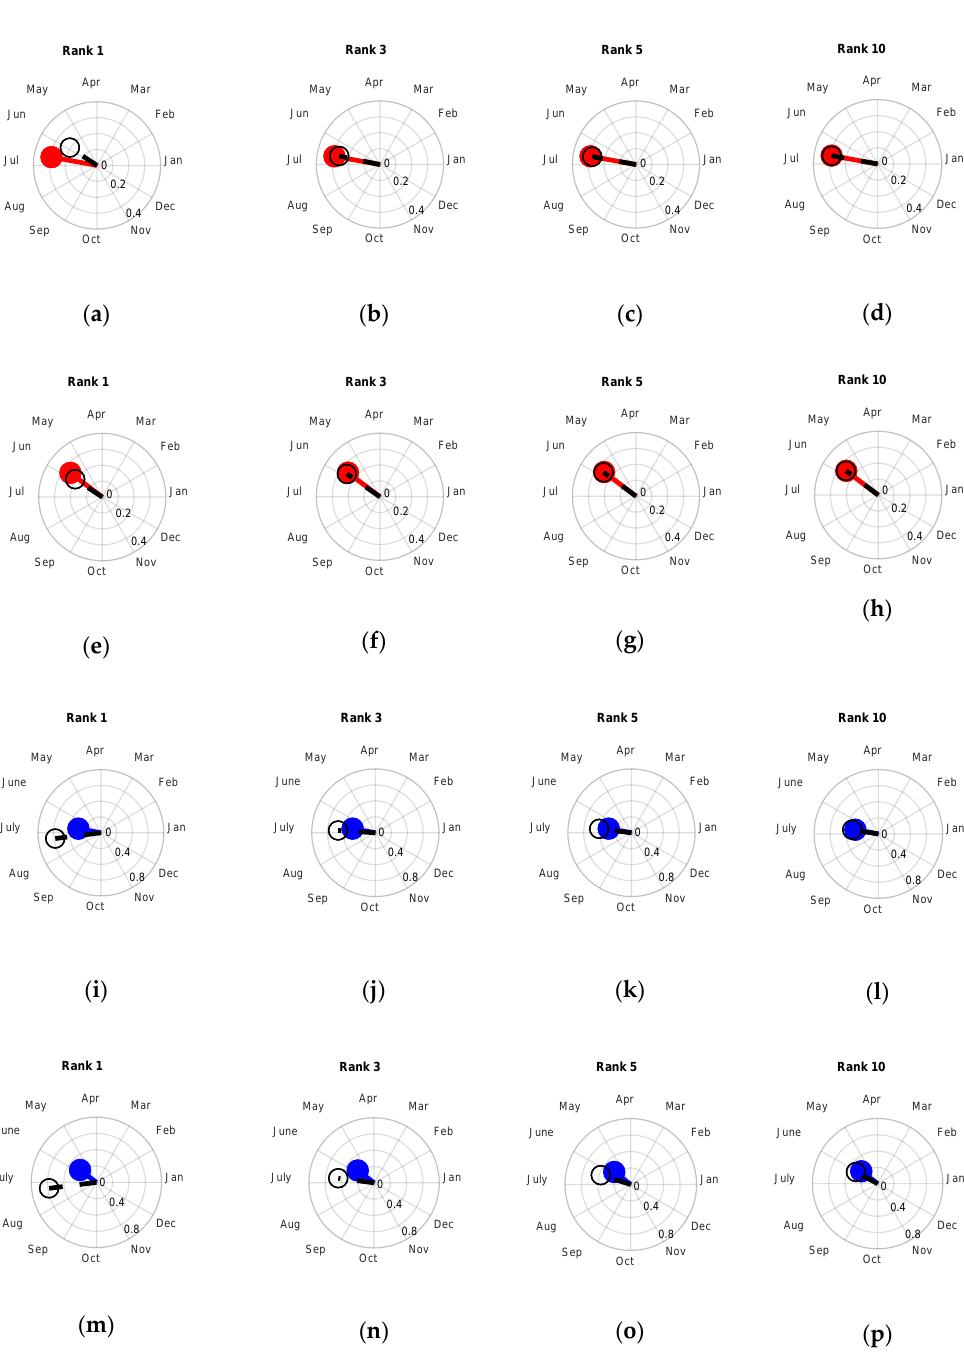
Figure 6. Comparison between the seasonality of the observed maximum annual peak-flow (red lines in ( a–d ); and blue lines in ( i – l ) and maximum annual volume (red lines e – h ; and blue lines ( m – p ) with respect to that obtained by applying different criteria (total depth ( a – h ) and maximum intensity ( i – p )) and accounting for different rank orders (up to one, three, five and ten), in which the predominant direction of the seasonality is represented by a circle with a black line. Table 3. Seasonality of the maximum annual peak-flow represented by the angle of its mean direction ( ) and its radio ( ), for different storm ranks and for the two different criteria studied. The relative error (RE) is also shown. θ� r ̅